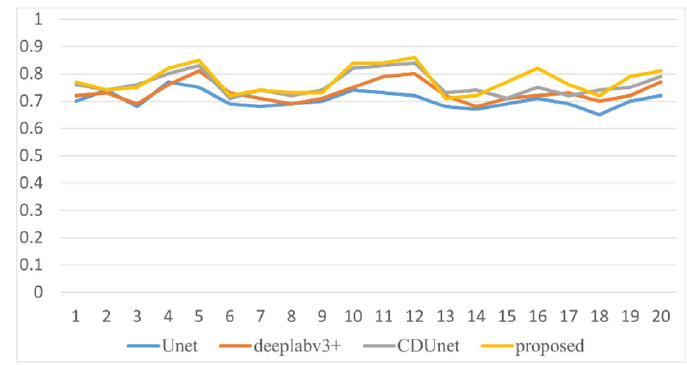
Figure 11. Comparison of mIoU values of different methods.